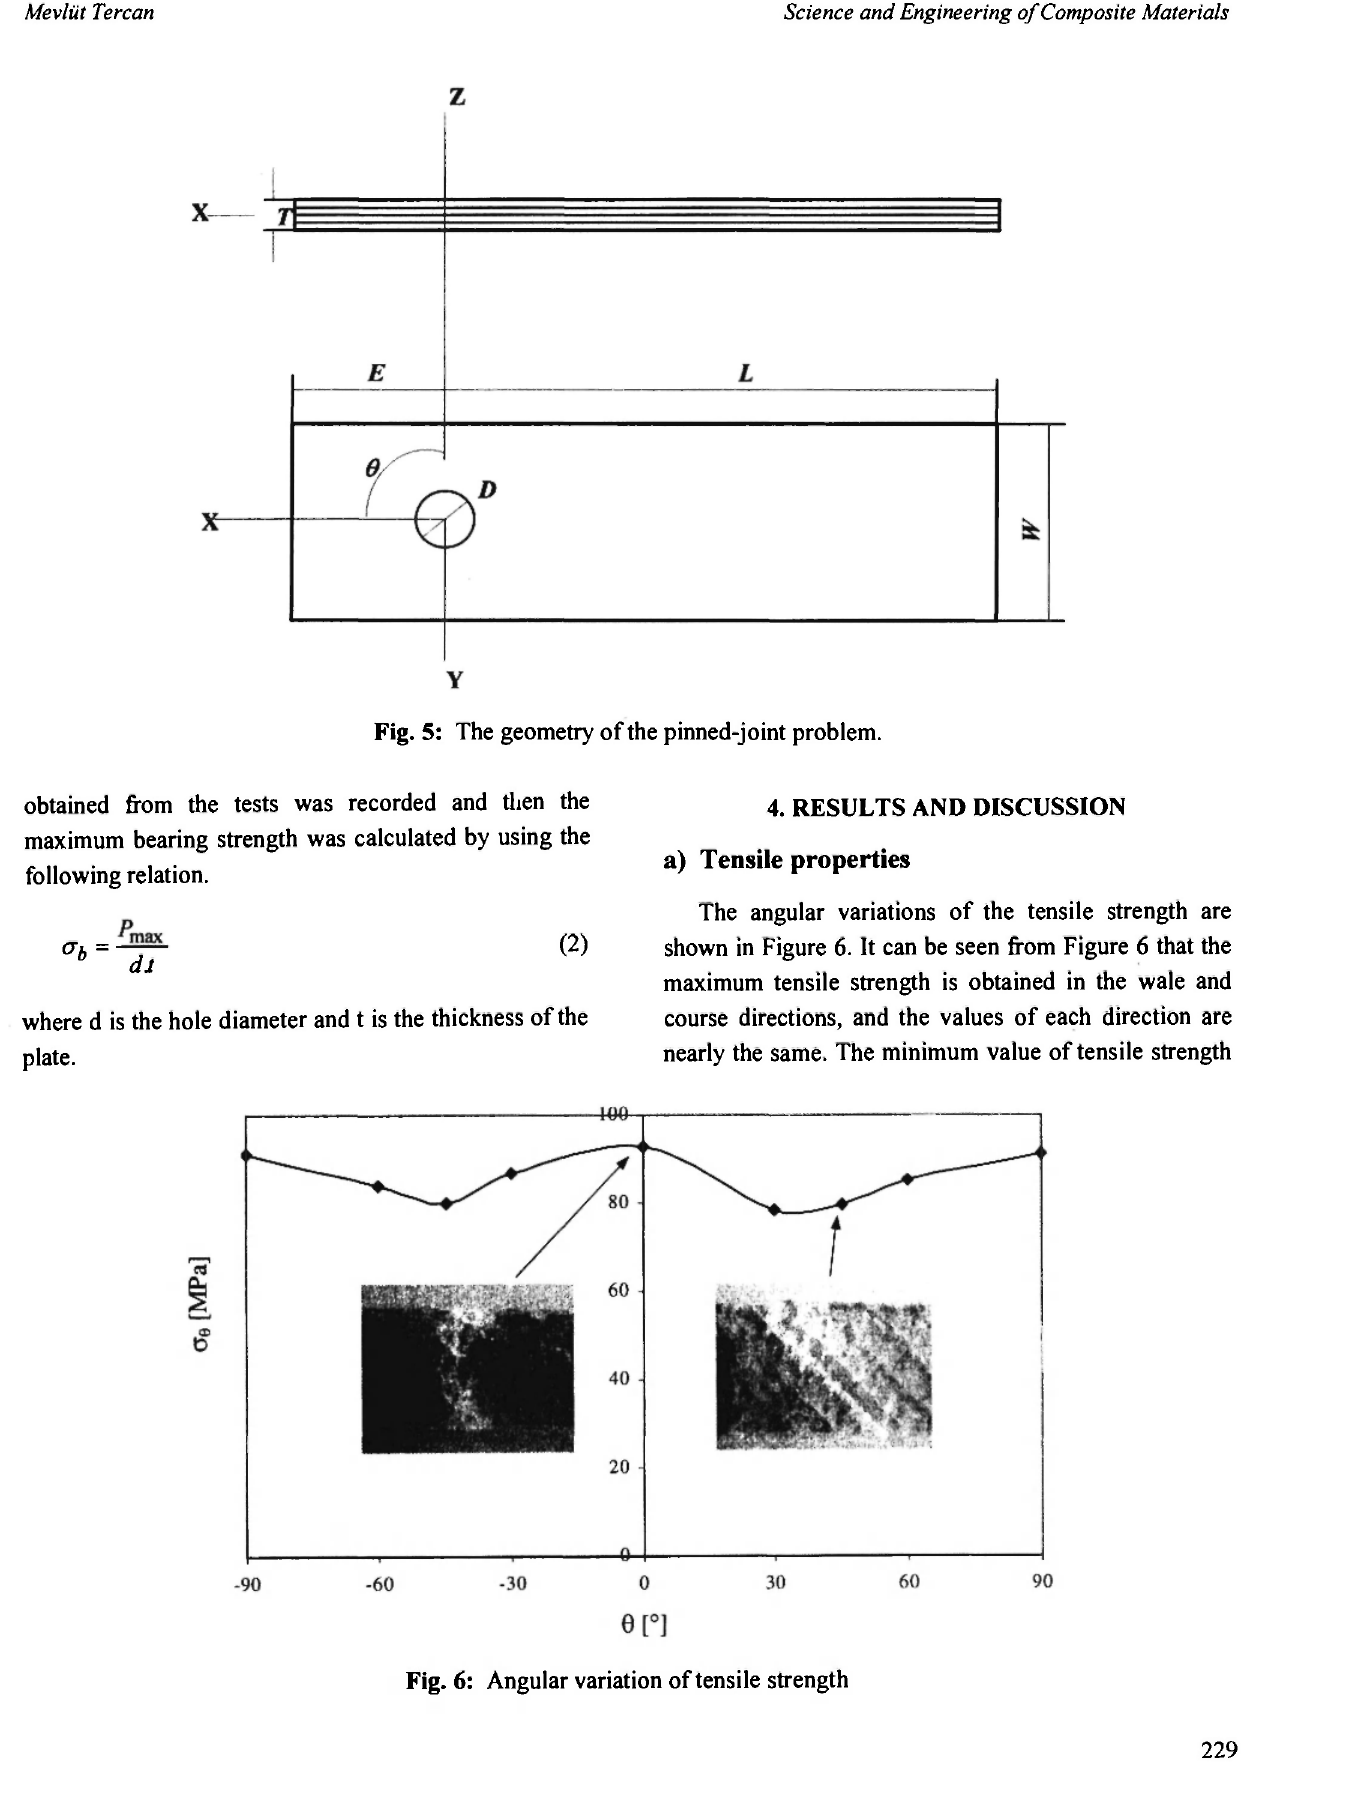
Fig. 6: Angular variation of tensile